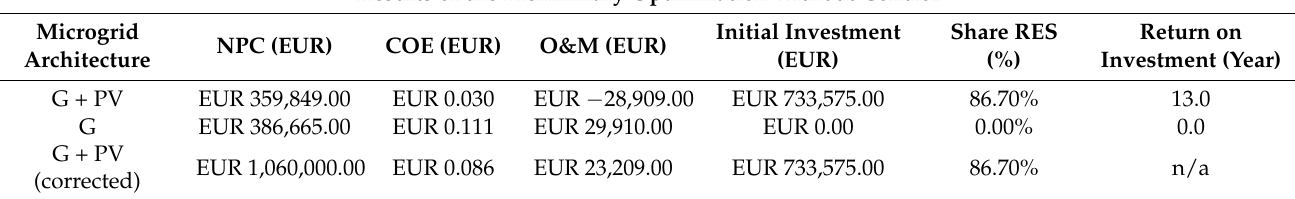
Table 5. Comparison of the optimization